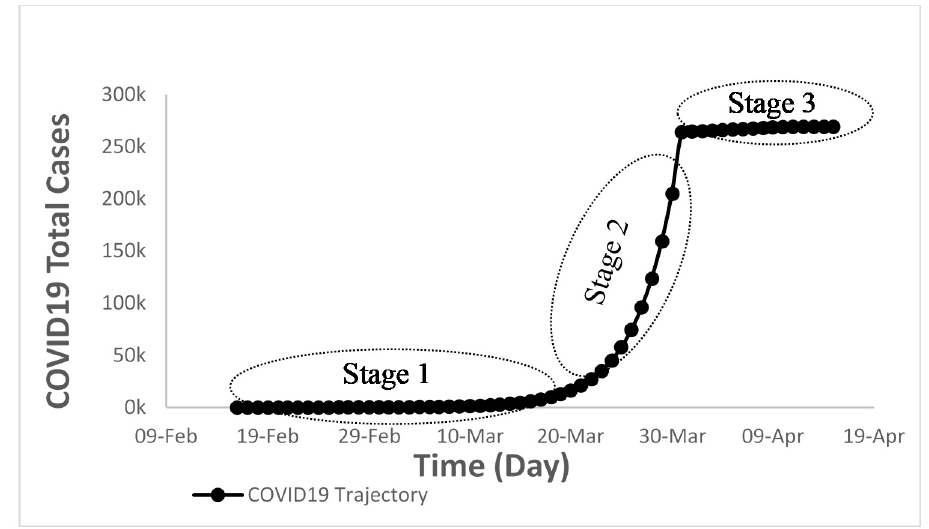
Figure 23. Three critical stages that novel COVID-19 is expected to go through.